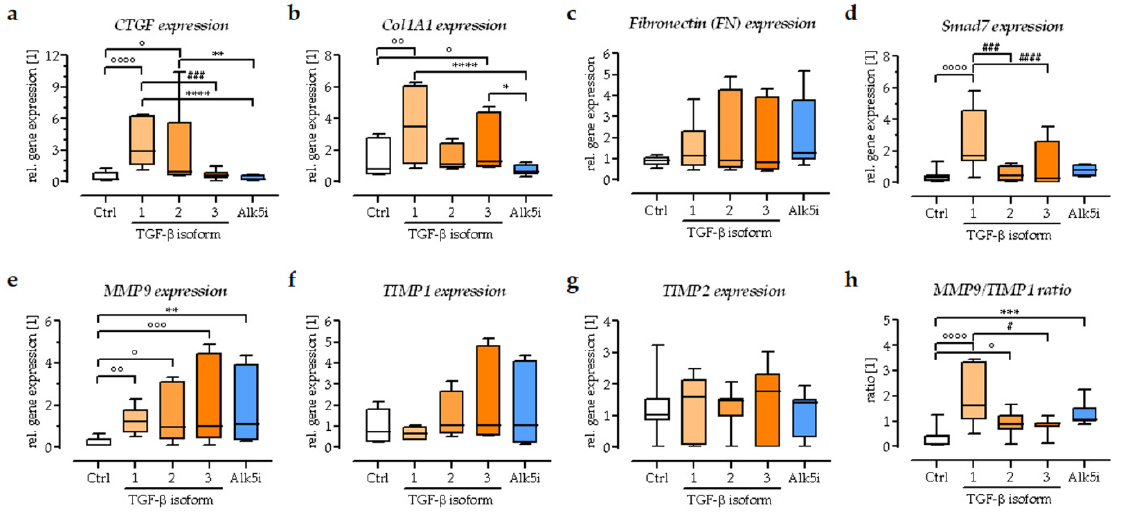
Figure 7. The expression of different ECM-related genes in the in vitro scabs. Gene expression was analyzed on day 14 of culture, normalized to the housekeeping genes, and represented as relative expression levels: ( a ) CTGF (connective tissue growth factor), ( b ) Col1A1 (collagen type 1 alpha-1), ( c ) FN1 (fibronectin), ( d ) inhibitory Smad7 , ( e ) matrix metalloproteinases MMP9 , ( f , g ) tissue inhibitor of metalloproteinases TIMP1 and TIMP2 were determined, ( h ) and the ratio of expressed MMP9 and TIMP1 . N = 4, n = 3. Data are presented as box plots. Data were compared by non-parametric one-way ANOVA followed by Dunn’s multiple comparison test. ° p = 0.05, °° p = 0.01, °°° p = 0.001, and °°°° p = 0.0001 as compared to Ctrl group. * p = 0.05, ** p = 0.01, *** p = 0.001, and **** p = 0.0001 as compared to Alk5i group. # p = 0.05, ### p = 0.001, and #### p = 0.0001 as indicated.